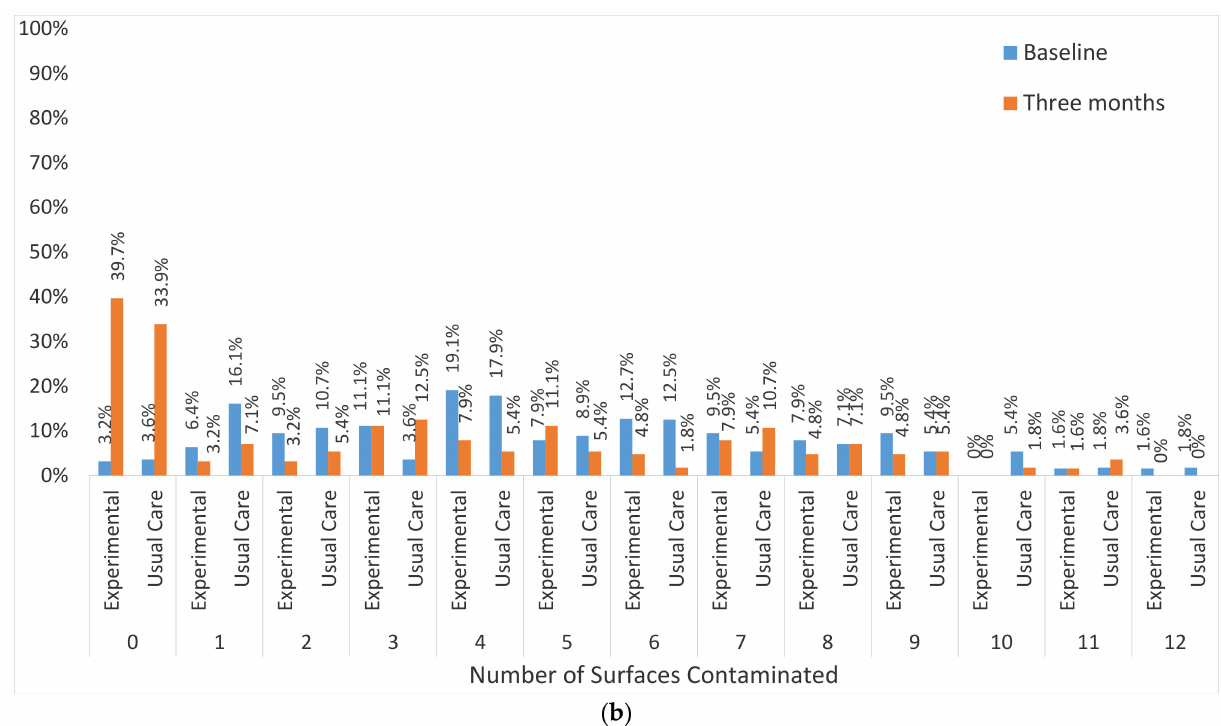
Figure 3. ( a ) Specific Household Surfaces Contaminated by S. aureus by Treatment Group at Baseline and Three Months Household Visit. ( b ). Numbers Household Surfaces Contaminated by S. aureus by Treatment Group at Baseline and Three